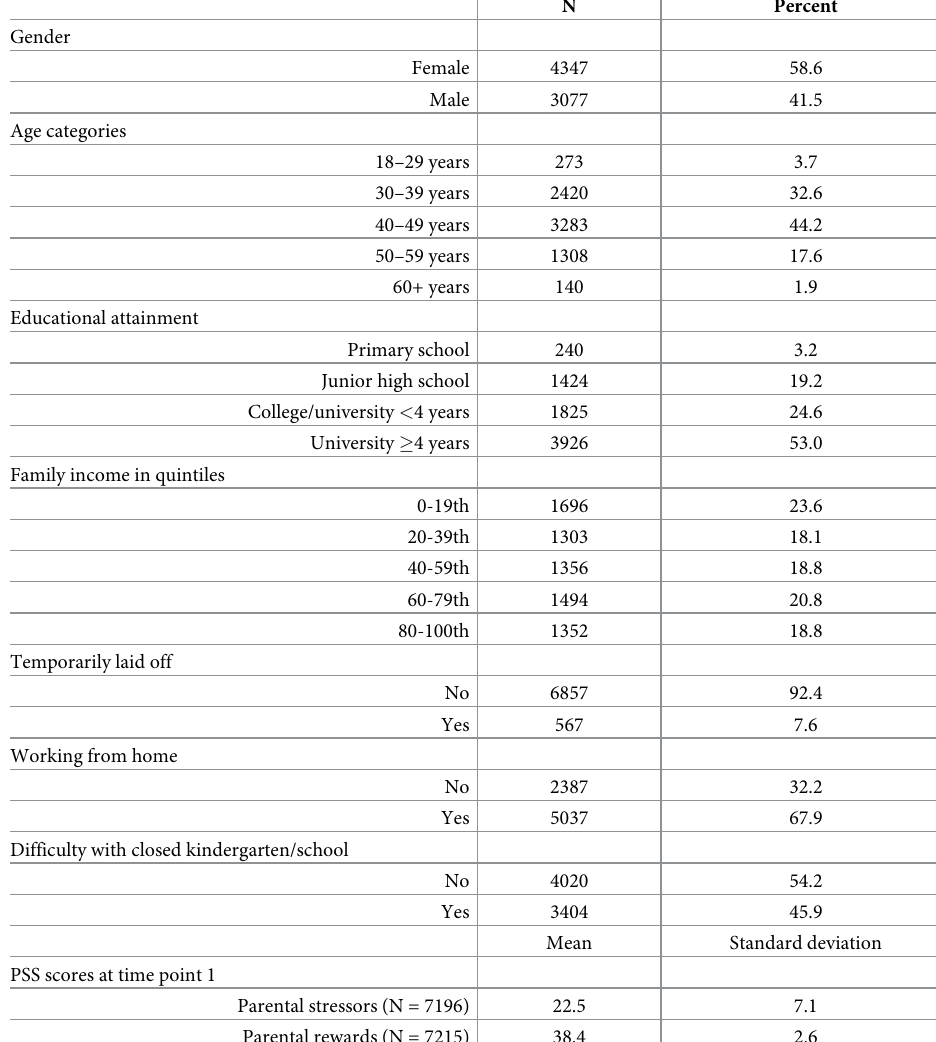
Table 1. Sample characteristics and parental stress scale (PSS) scores at time point